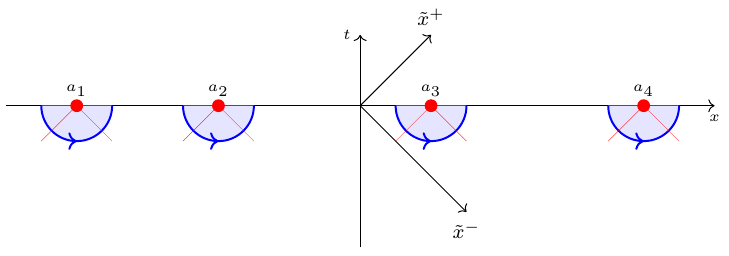
Figure 7 . The domain of integration R for (4.26) is the lower half space t < 0 with half-discs U δ around each a removed. The imaginary contributions to ∂ i i past of a i